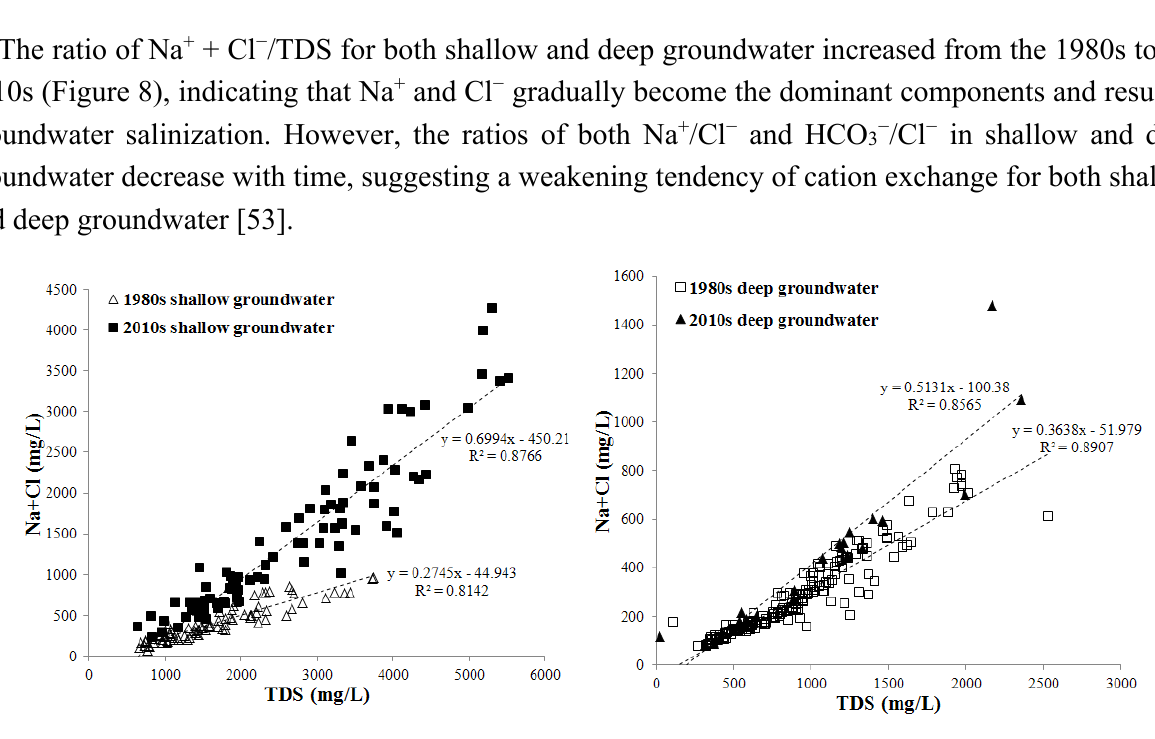
Figure 8. Scatter diagram of Na + + Cl − vs. total dissolved solids (TDS) of groundwater samples in shallow and deep groundwater in the 1980s and the